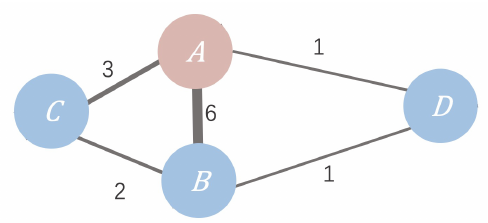
Figure 4. Schematic diagram of scholar cooperation. The number between scholars indicates the number of articles written in